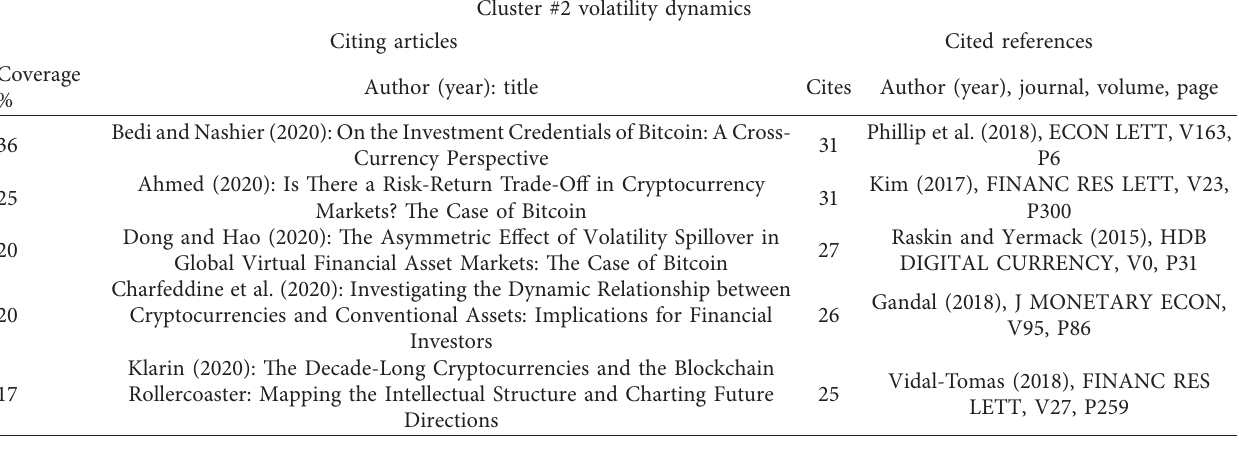
Table 5: Citing articles and cited references of Cluster #2.